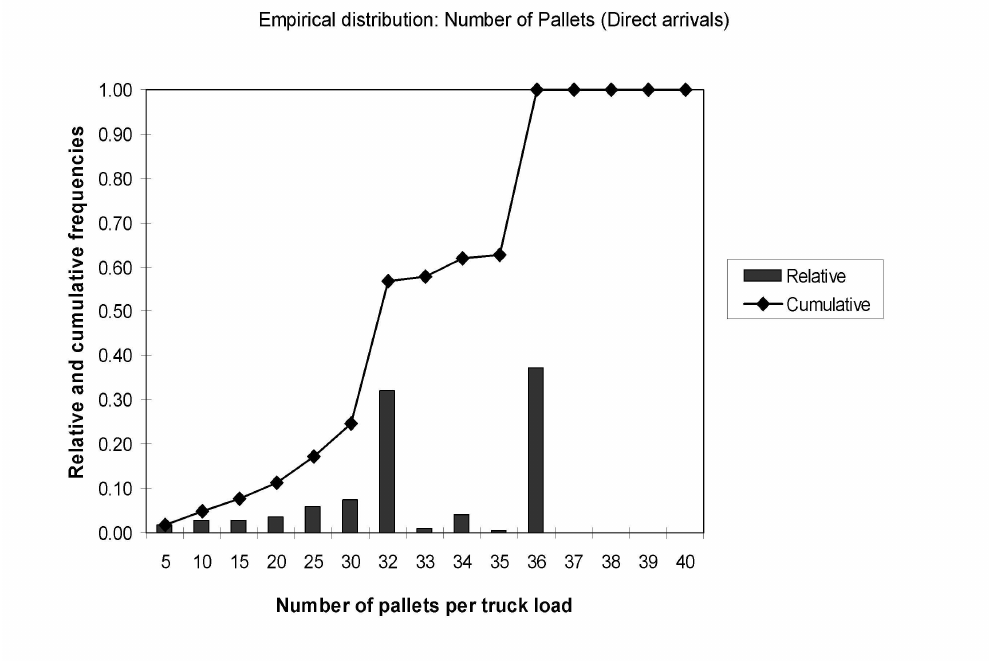
Figure 4: Histogram and empirical distribution: Number of pallets (Direct).